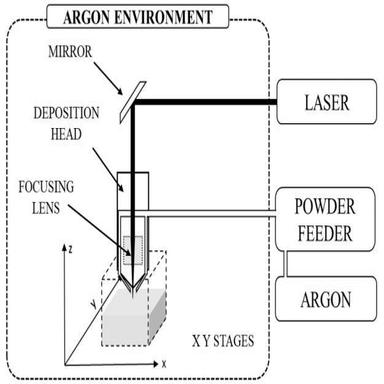
Schematic diagram of laser-DED process.